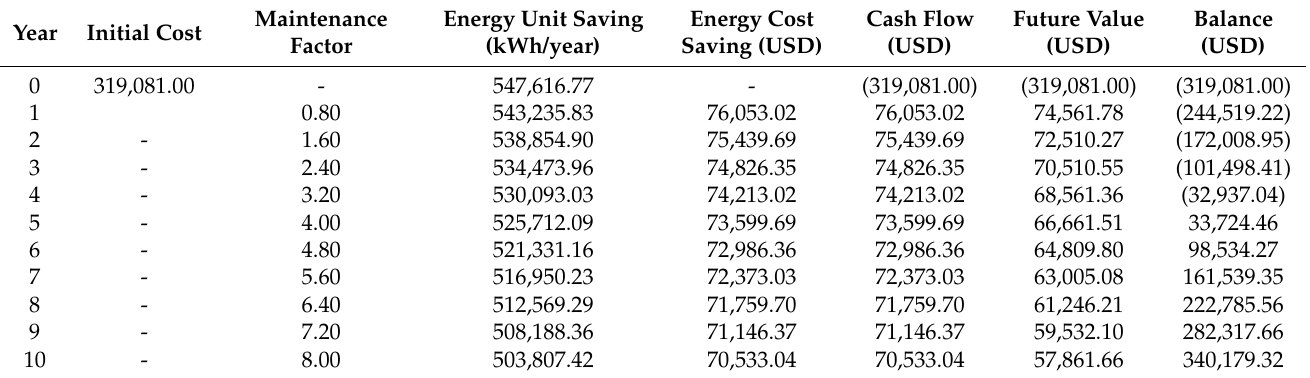
Table 22. Annual cash flow of the retrofitting project.